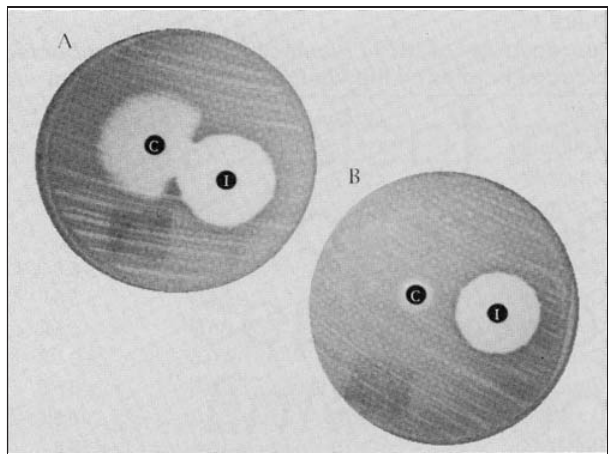
contour-clamped homogeneous electric field apparatus